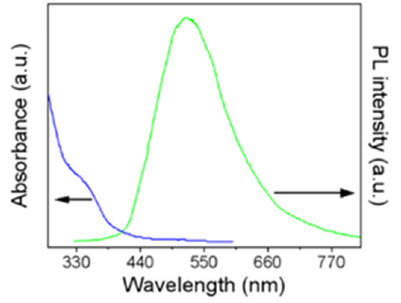
Figure 2. Absorption and PL spectra of MoS 2 QD colloid.